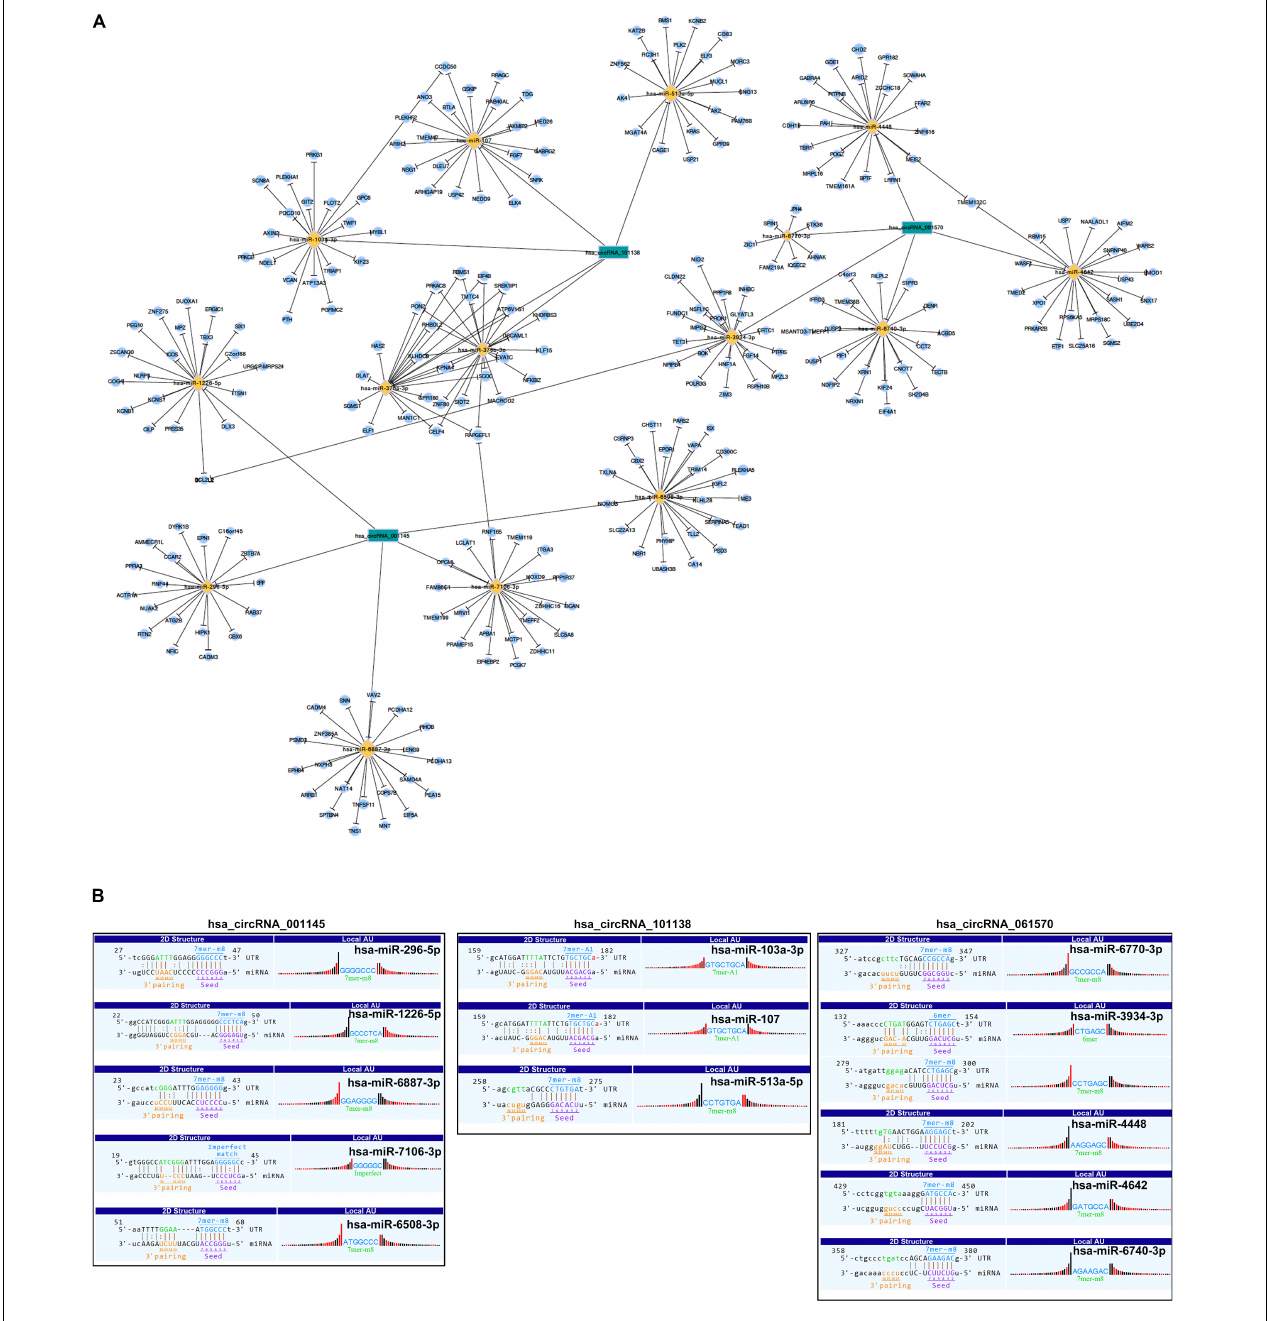
FIGURE 5 | Representative circRNA–miRNA–mRNA network and sequence pairing predictions for circRNAs and miRNAs. (A) Based on the circRNA microarray profile results, the co-expression network drawn by Cytoscape software showing the dysregulated circRNAs, hsa_circ_001145, hsa_circ_101138, and hsa_circ_061570 (green nodes), having the highest magnitude of change and which were predicted to be functionally connected with their targeted miRNAs in the network. (B) Seed sequence matching predicted the direct interaction of the abovementioned circRNAs with their related miRNAs.